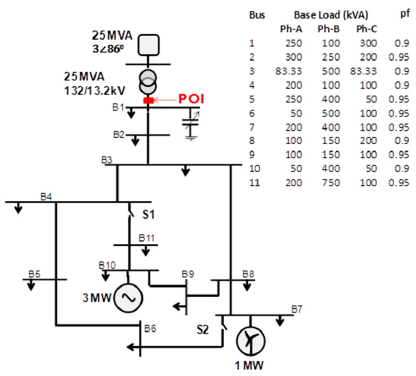
Figure 14. Microgrid test system.